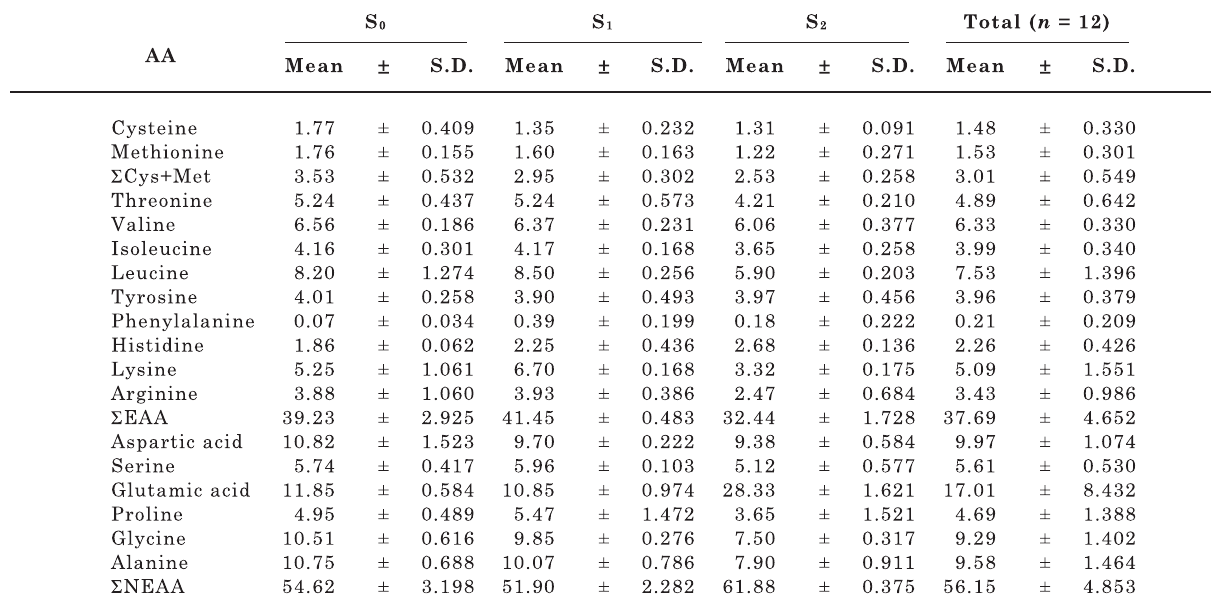
, S and S (g/16 g 0 1 2